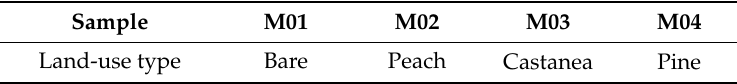
Table 1. The sample number and land-use type.